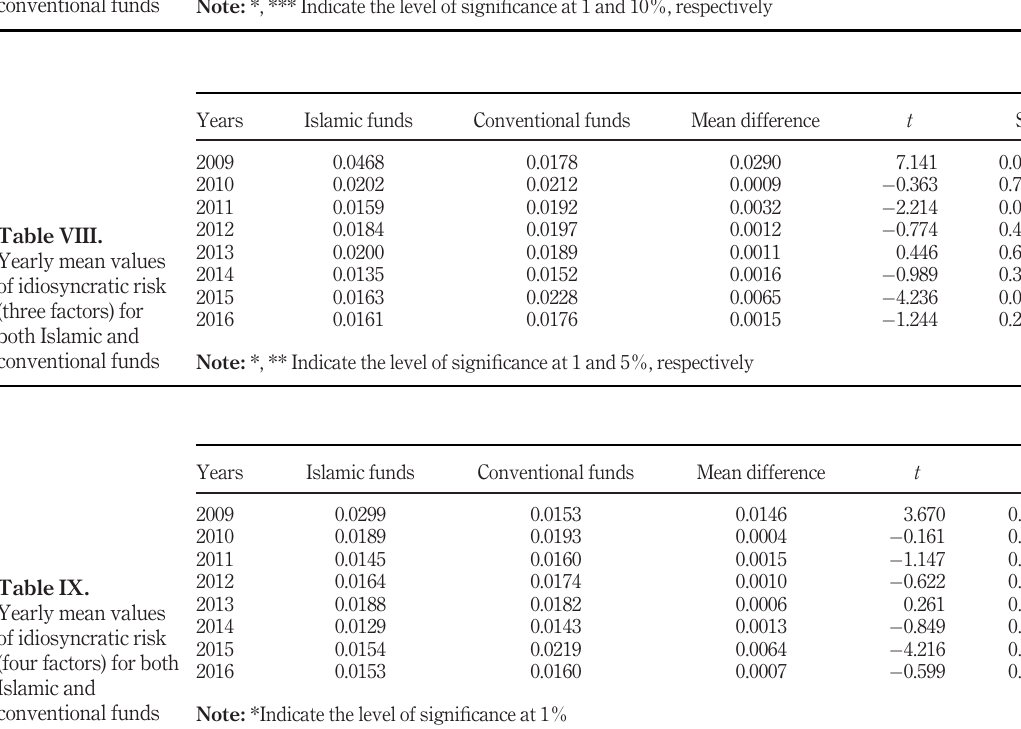
Table VII. Yearly mean values of idiosyncratic risk (CAPM) for both Islamic and